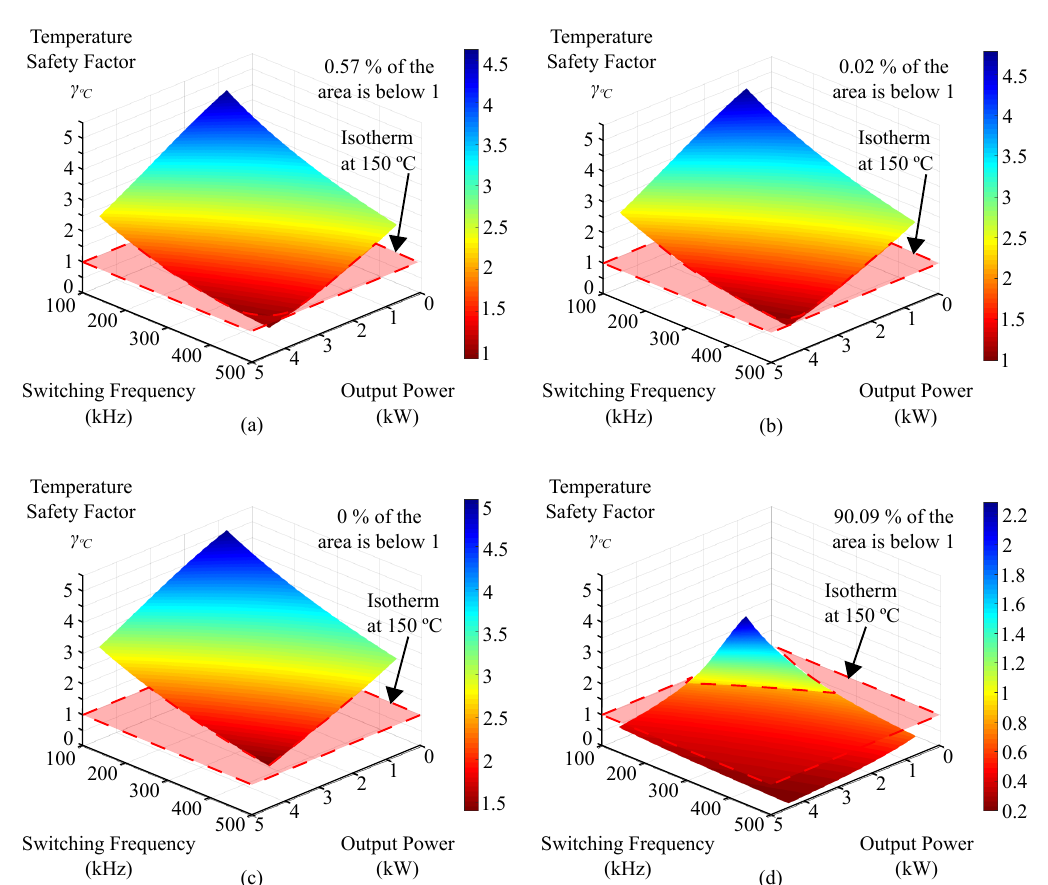
Figure 11. Junction temperature safety factor: ( a ) bottom-side cooled converter; ( b ) top-side cooled converter with graphite- enhanced and polymeric TIMs; ( c ) top-side cooled converter with a graphite-enhanced TIM; and ( d ) top-side cooled converter with a polymeric